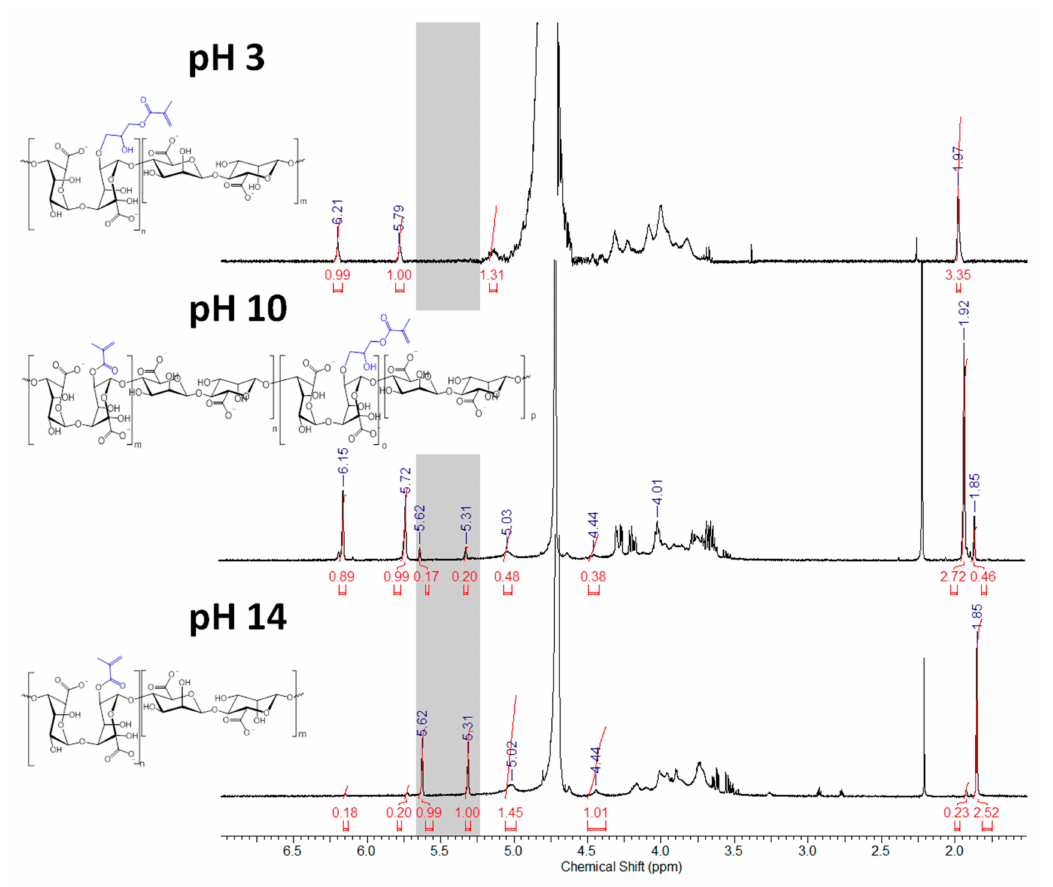
Figure 4. 1 H-NMR spectra of ALGMx macromers obtained by the grafting of M1 at varying reaction pHs. The gray zone marks the chemical shift range of the shielded vinyl hydrogens resulting from the grafting via the methacryloyl subunits (5.25–5.65 ppm). D20 was used as a solvent in all